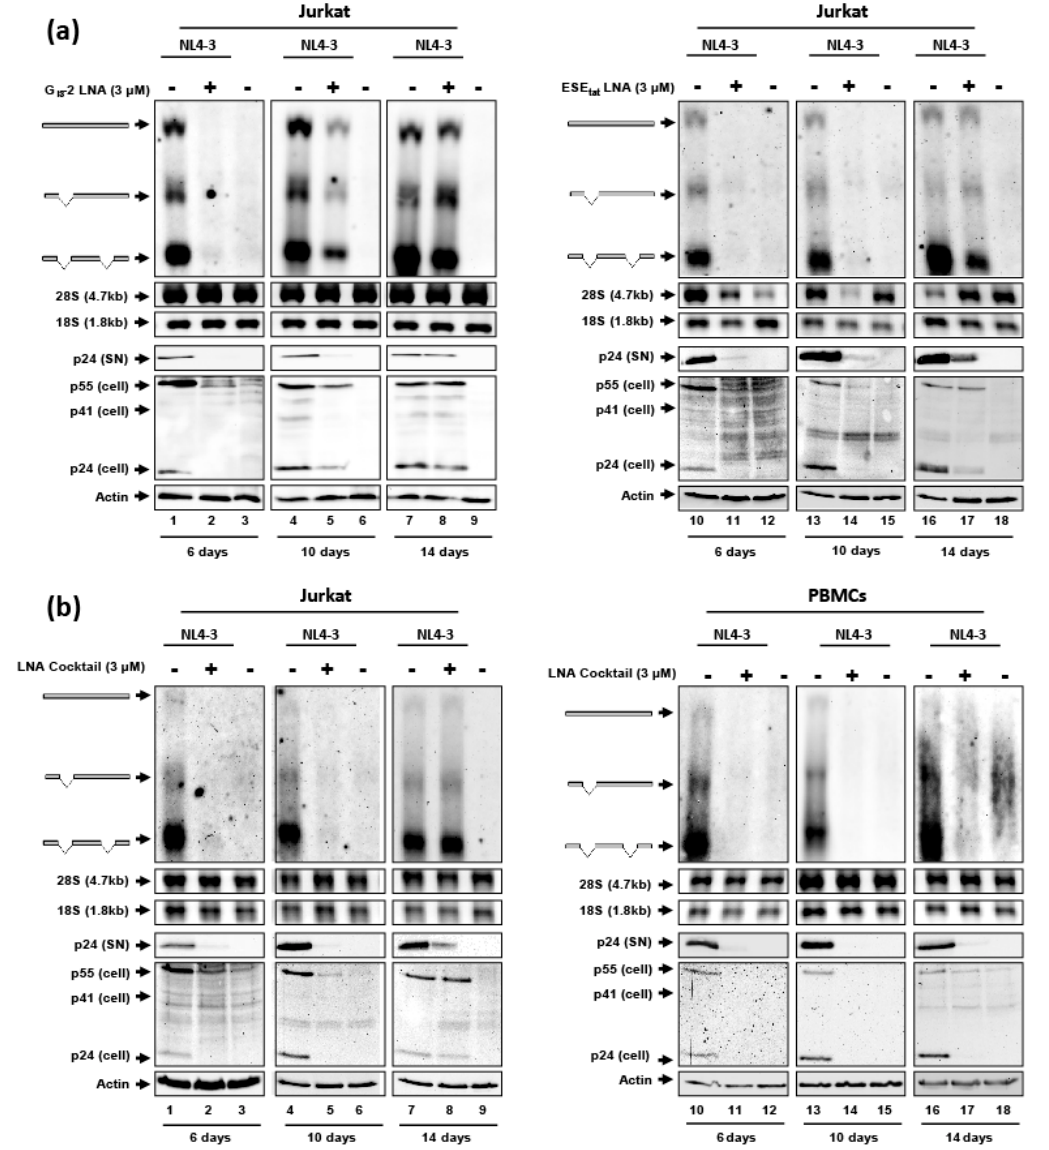
Figure 5. Antiretroviral effect of the gymnotically-delivered G I3 -2 and ESE tat LNA mixmers. Jurkat and PBMCs were infected with the laboratory HIV-1 strain NL4-3 (MOI: 0.005). Six hours post infection 3 µ M of the G I3 -2 or ESE tat LNA ( a ) or both combined as an LNA cocktail ( b , 1.5 µ M of each LNA) were added to the cell culture medium. After 6 days, 10 days or 14 days total RNA and proteins, as well as virions from the supernatant were harvested. Viral mRNA classes were detected performing northern blot analysis using a DIG-labeled HIV-1 exon 7 probe. p24 CA protein levels were determined by immunoblot analysis using an anti-p24 CA antibody. Lanes 3, 6, 9, 12, 15 and 18 represent mock